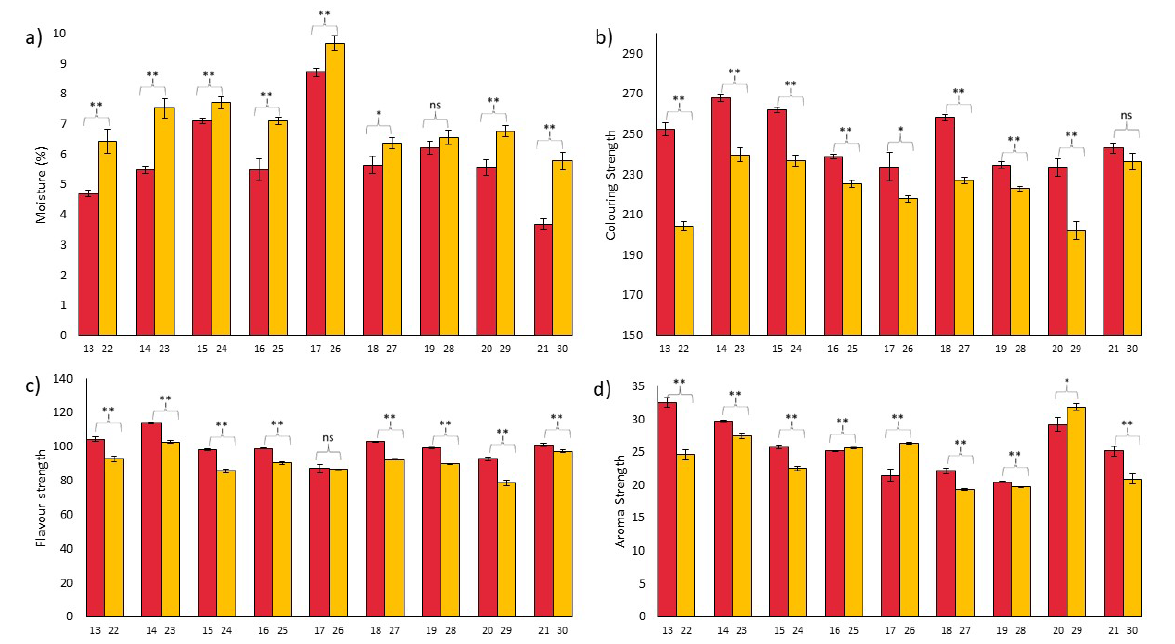
Fig. 5: Quality parameters of saffron samples: (a) moisture content (b) colouring (c) flavour (d) aroma strength of saffron correctly cleaned/“ mondato ” – red, and saffron uncleaned where stigmas are whole kept and dried - orange. Key: *, significantly different if p <0.05; **, very significantly different if p < 0.01; ns, not significantly different. Numbers are the codes of the samples and samples coupled are from same field. Tab. 3: The means of the two groups (saffron cleaned (“ mondatura” ) and uncleaned) are compared and considered significantly: *, p <0.05; **, p <0.01; ns, not significantly